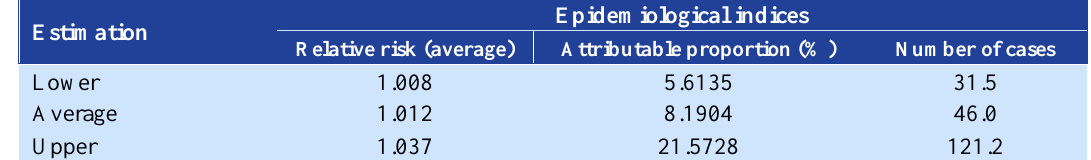
Table 3. The estimation of relative risk indices, attributable proportion, and number of cases of respiratory tract disease mortality (BI = 66) in Kermanshah in 2011